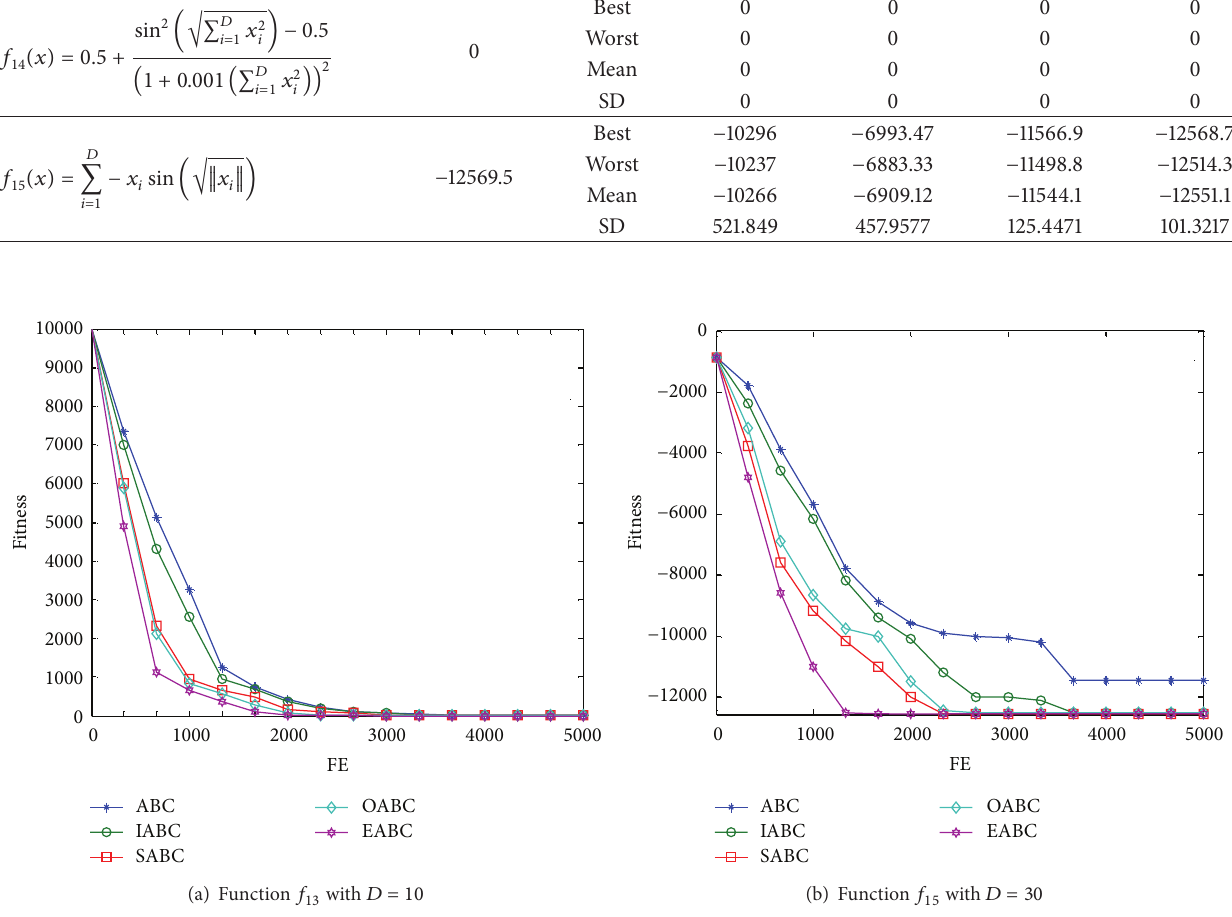
Figure 1: Convergence speed of the different ABCs on the two test functions ( 𝑓 13 , 𝑓 15